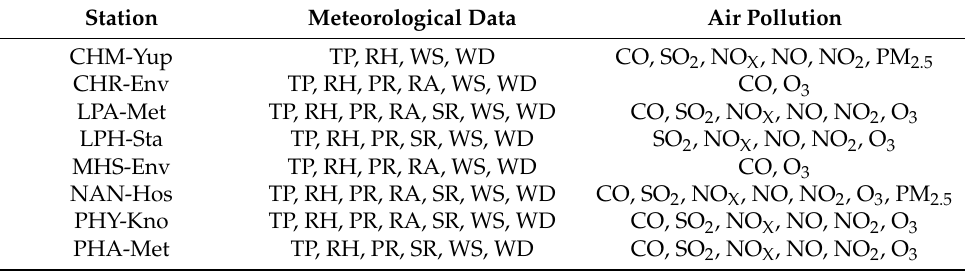
Table A1. List of parameters from eight stations divided by the type of data. Station Meteorological Data Air